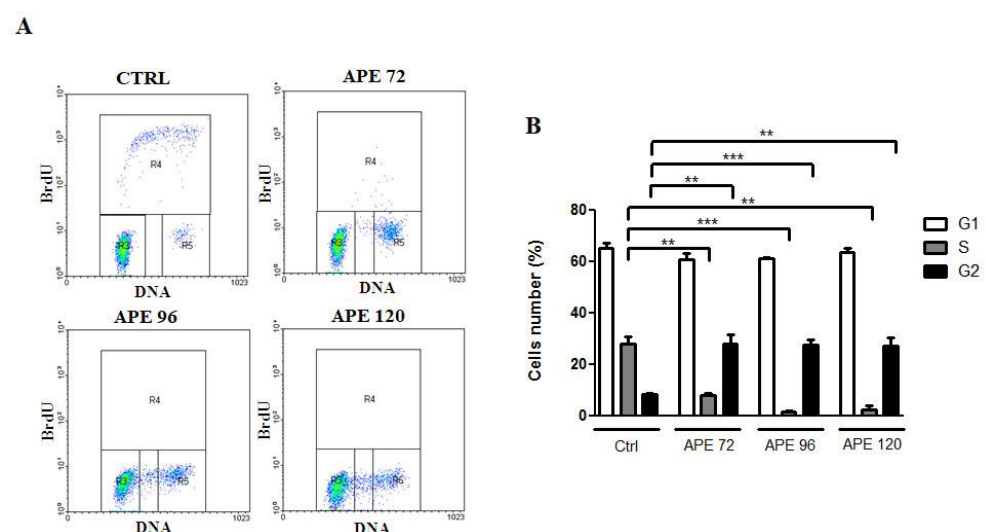
Figure 3. ( A ) Bivariate analysis of BrdUrd incorporation and DNA content in GB7 cells at 72, 96 and 120 h after 100 µ M APE treatment. ( B ) Percentage of GB7 cells in G1, S, and G2 / M phases after 100 µ M APE treatment. (t-test; ** p < 0.01; *** p < 0.001). The data are the average ± SEM of three independent experiments.